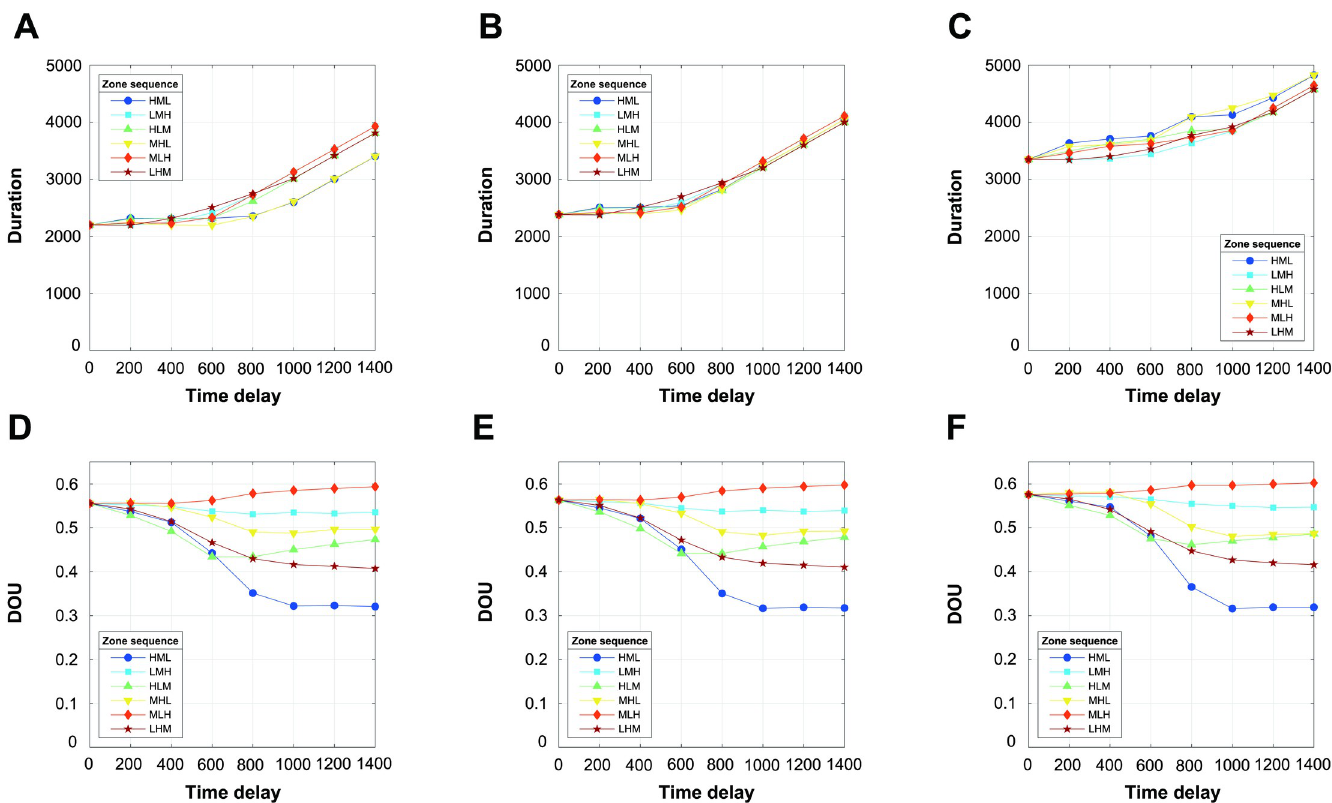
Fig 4. Mean evacuation duration and mean DOU, averaged over 500 simulations, as a function of the time delay under the different shelter capacity distributions and institutional arrangements. A time delay of zero indicates simultaneous evacuation. Each column represents a different shelter capacity: (A, D) uniform, (B, E) moderately nonuniform, and (C, F) strongly